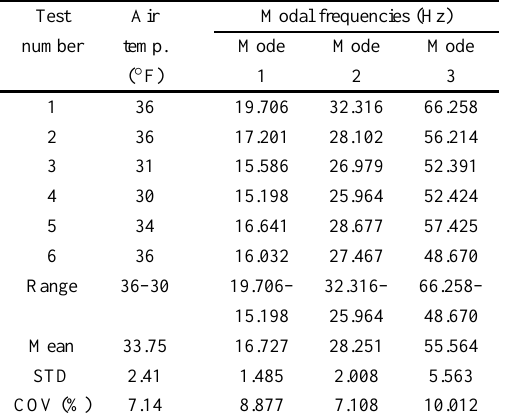
Variation of modal frequencies of field bridge, with simulated damage, at below-freezing